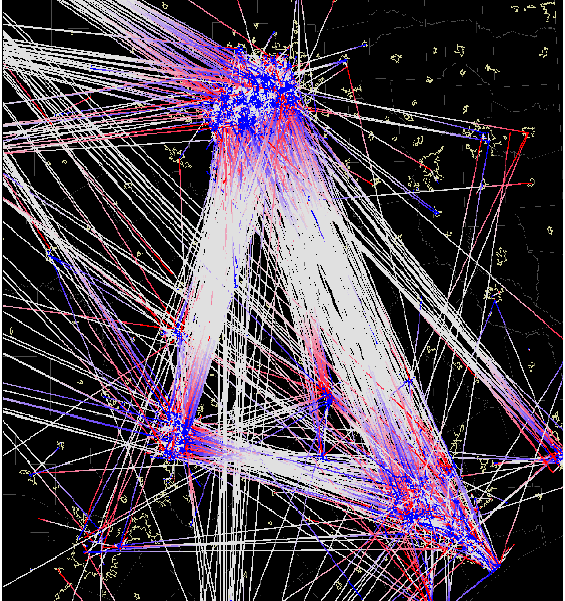
Figure 4. ‘Texas Triangle’ map